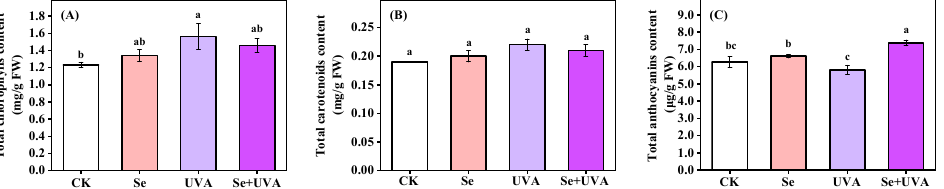
Figure 2. The contents of total chlorophylls ( A ), total carotenoids ( B ) and total anthocyanins ( C ) in broccoli microgreens under Se (100 μ mol/L Na 2 SeO 3 ), UVA (40 μ mol/m 2 /s), and combined treatments. The vertical bars indicated standard errors, n = 3. Different lower-case letters above the bars indicated significant differences between treatments by Duncan’s multiple range test at a level of 0.05. Table 2. The interaction effects of Se and UVA on pigments contents of broccoli microgreens. Pigments Contents Interaction